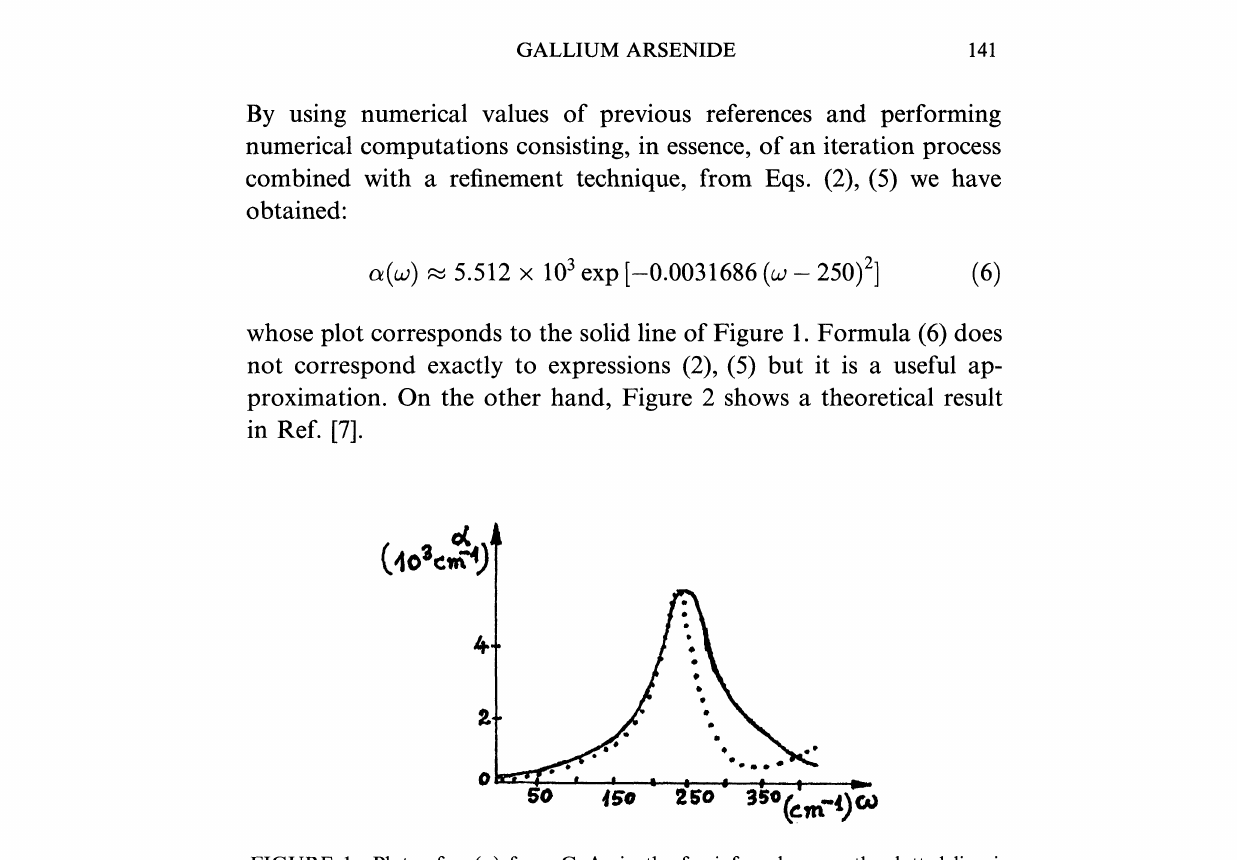
FIGURE 2 Theoretical plot of a (co) for a-GaAs in the far infrared range after Ref.